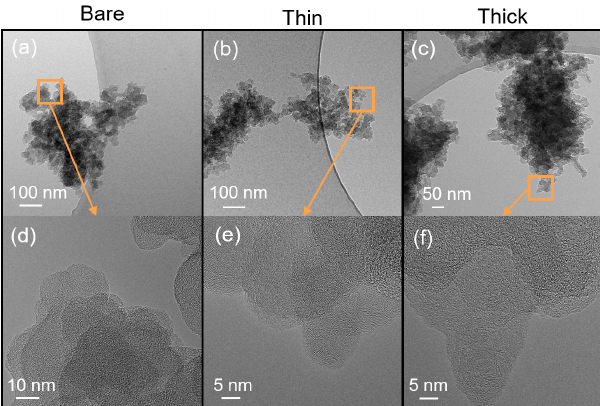
Figure C5. HR-TEM images for fine structures of 200nm size- selected bare and coated FW200 soot particles. Scale bars are indi- cated in each image. (a, d) Bare particles, (b, e) thinly coated par- ticles with a coating wt = 2.3%, and (c, f) thickly coated particles with a coating wt = 139.3%. All images taken with TFS